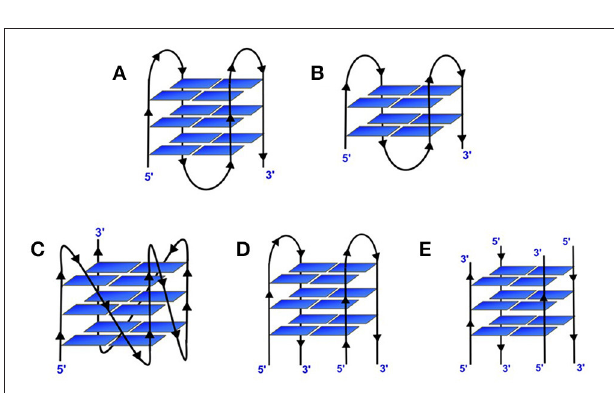
FIGURE 3 | Different topological variants of G-quadruplexes. (A) Intramolecular antiparallel 3-tiered GQ; (B) Intramolecular antiparallel 2-tiered GQ; (C) Intramolecular parallel 3-tiered GQ; (D) Bimolecular antiparallel 3-tiered and (E) Tetramolecular antiparallel 3-tiered